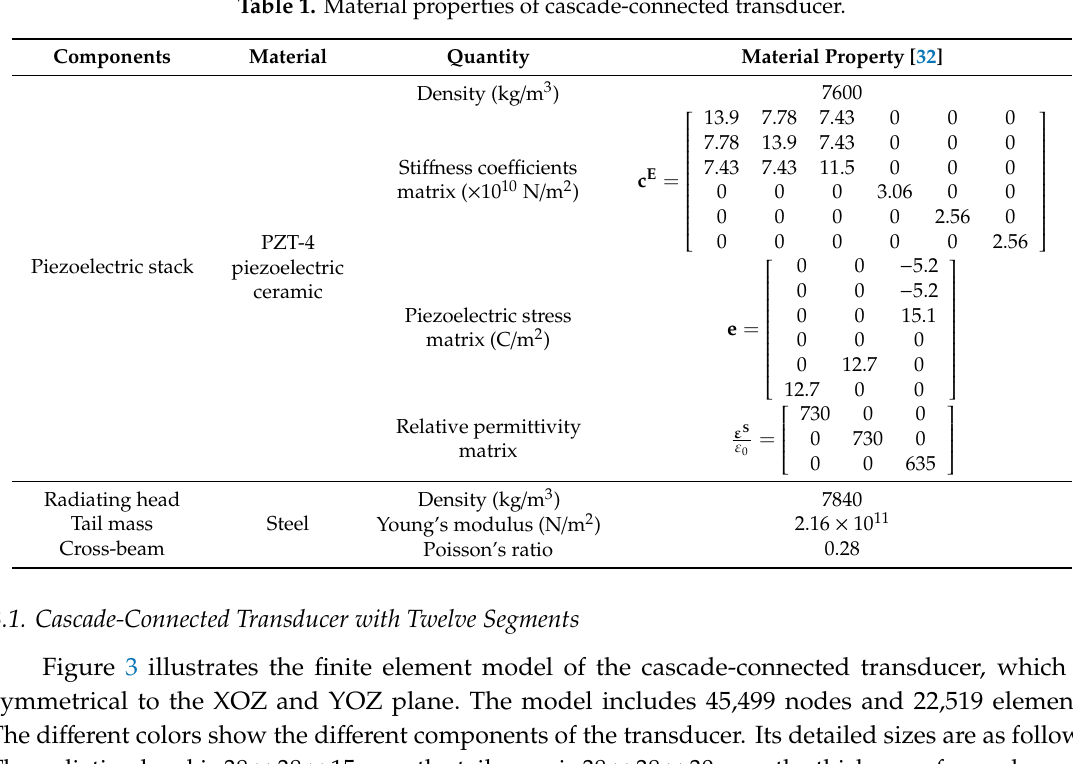
Figure 4. Vector illustration of vibration at 957.5 Hz (cascade-connected transducer with twelve segments).